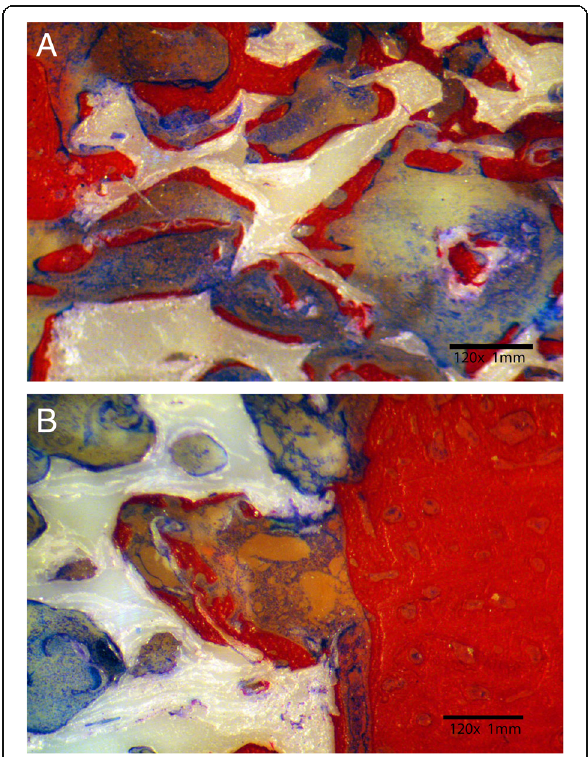
Fig. 3 a Histological section demonstrating bone growth in control zirconia scaffold ( white arrow ). Mineralized bone formation ( black arrow ) was less dense compared to HA-enriched scaffolds. b Histological section showing different sizes of pores present in porous zirconia scaffolds (Control specimen). Mineralization started by lining pore walls ( white arrow ). Unmineralized bone stained blue